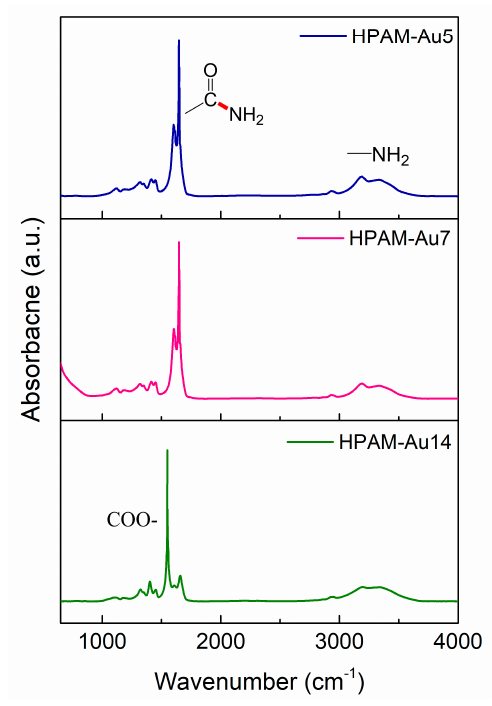
Figure 2. ATR – FTIR spectra comparison between nanocomposites prepared at different pHs: Figure 2. ATR–FTIR spectra comparison between nanocomposites prepared at different HPAM – Au5 (acidic), HPAM – Au7 (neutral), HPAM – Au14 (basic).